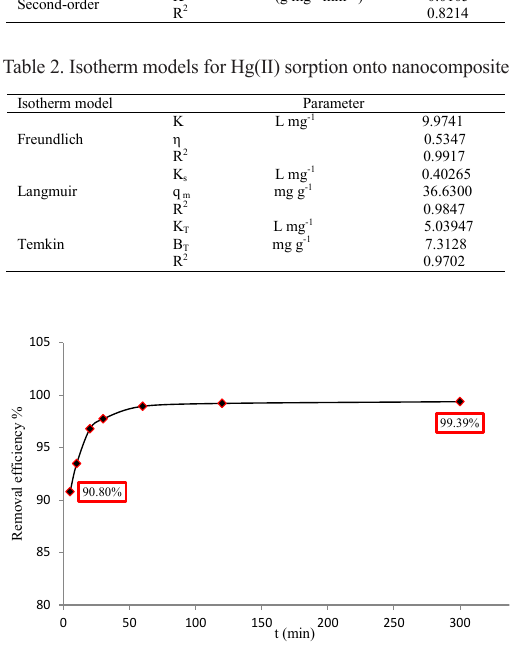
Fig.4: EffectsofcontacttimeontheadsorptionofHg(II)ontoFe 3 O 4 -Polyrhodanine Fig. 4: Effects of contact time on the adsorption of Hg (II) onto Fe3O4